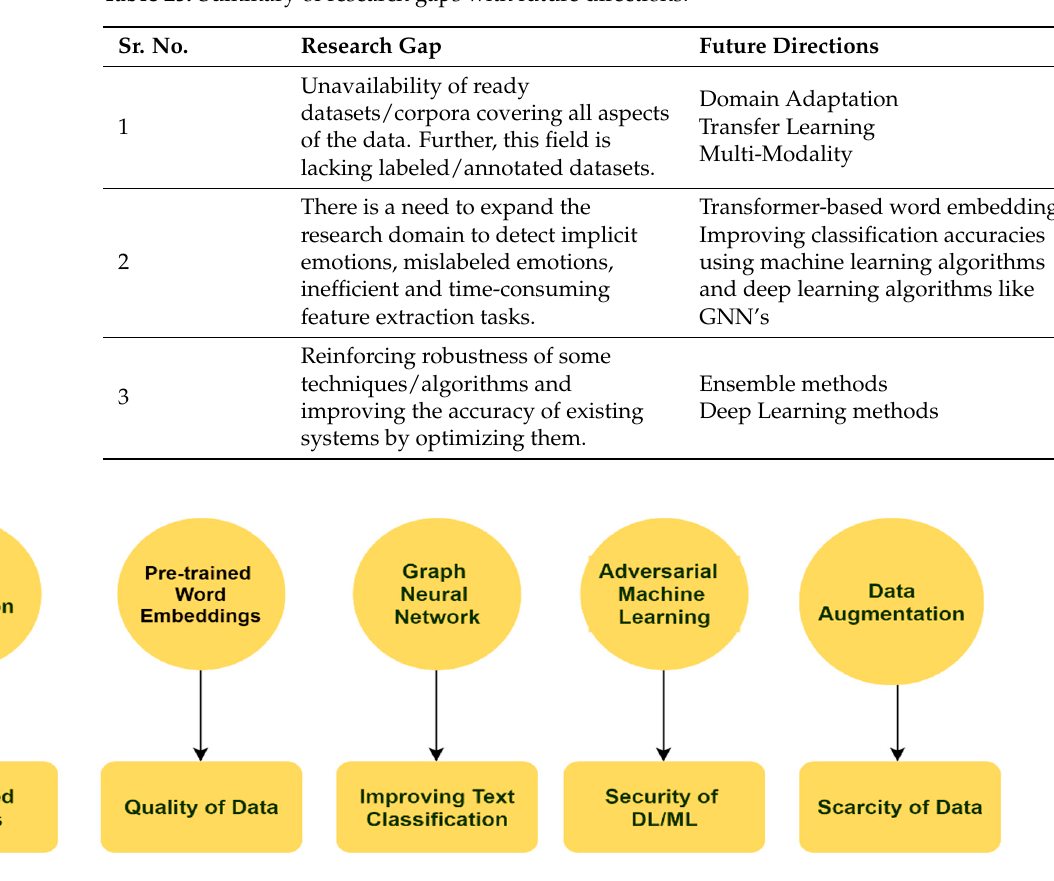
Figure 24. Future Directions for text-based emotion detection Using AI.